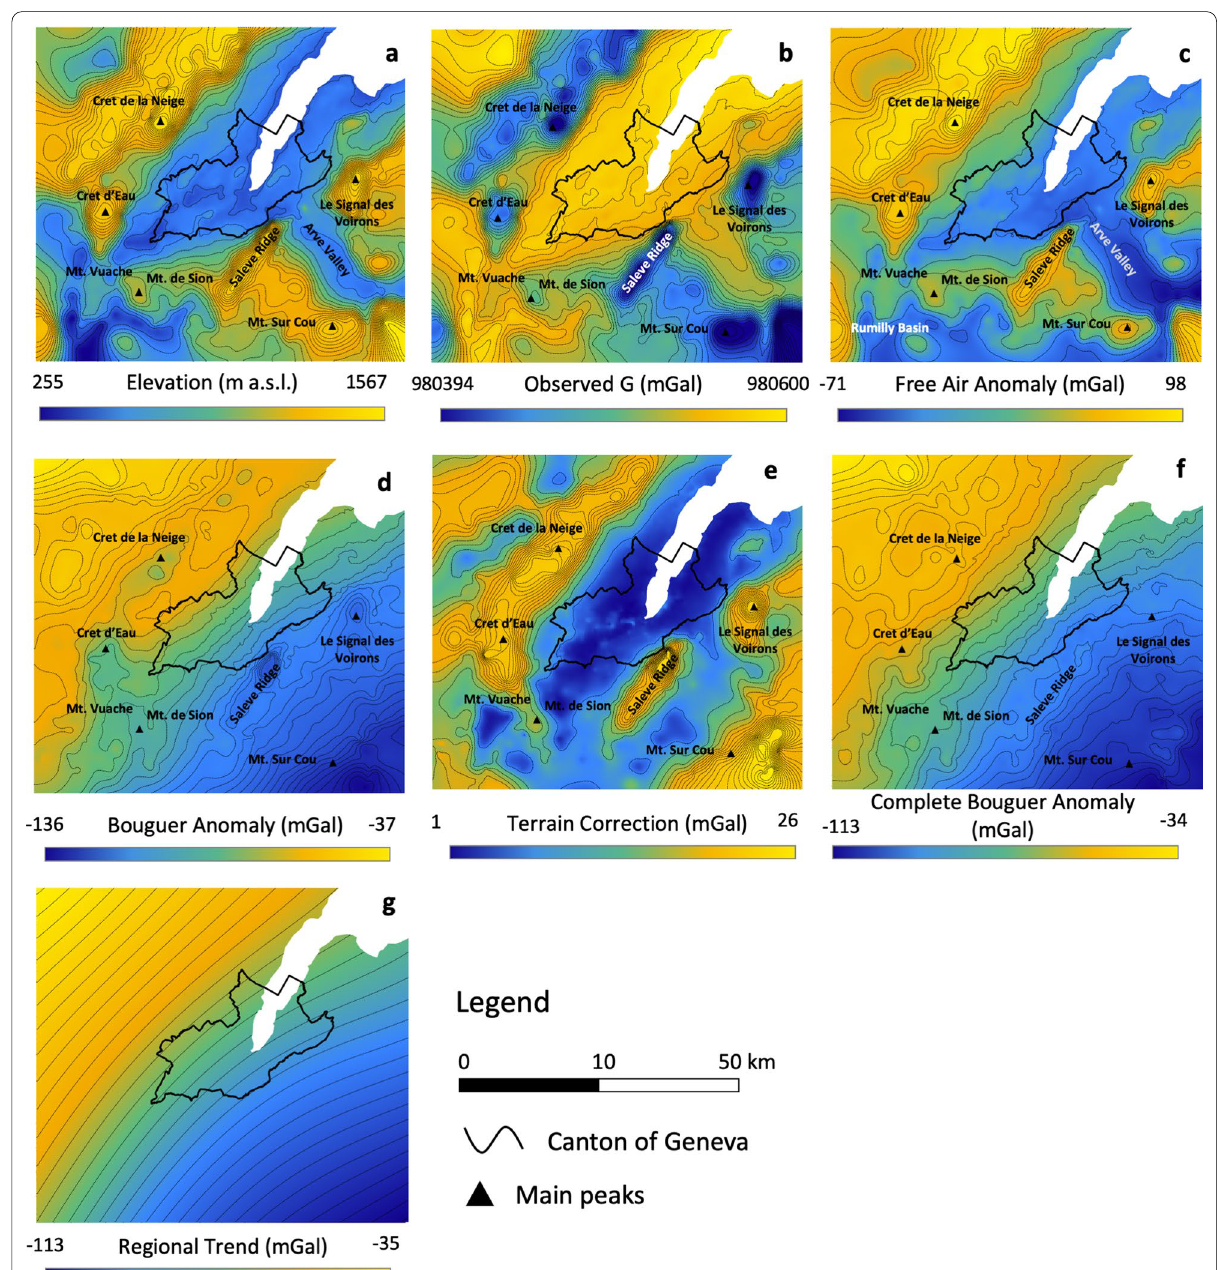
Fig. 6 a Elevation map; b observed gravity; c free-air anomaly; d Bouguer anomaly; e terrain correction; f complete Bouguer anomaly; g gravity regional